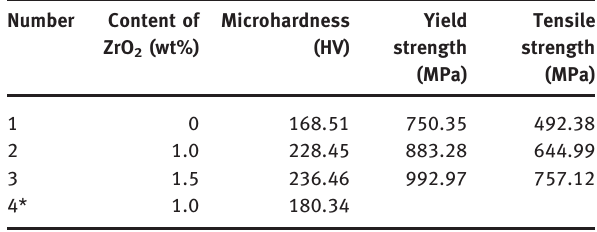
Table 2: Physical property of ZrO 2 /Mo